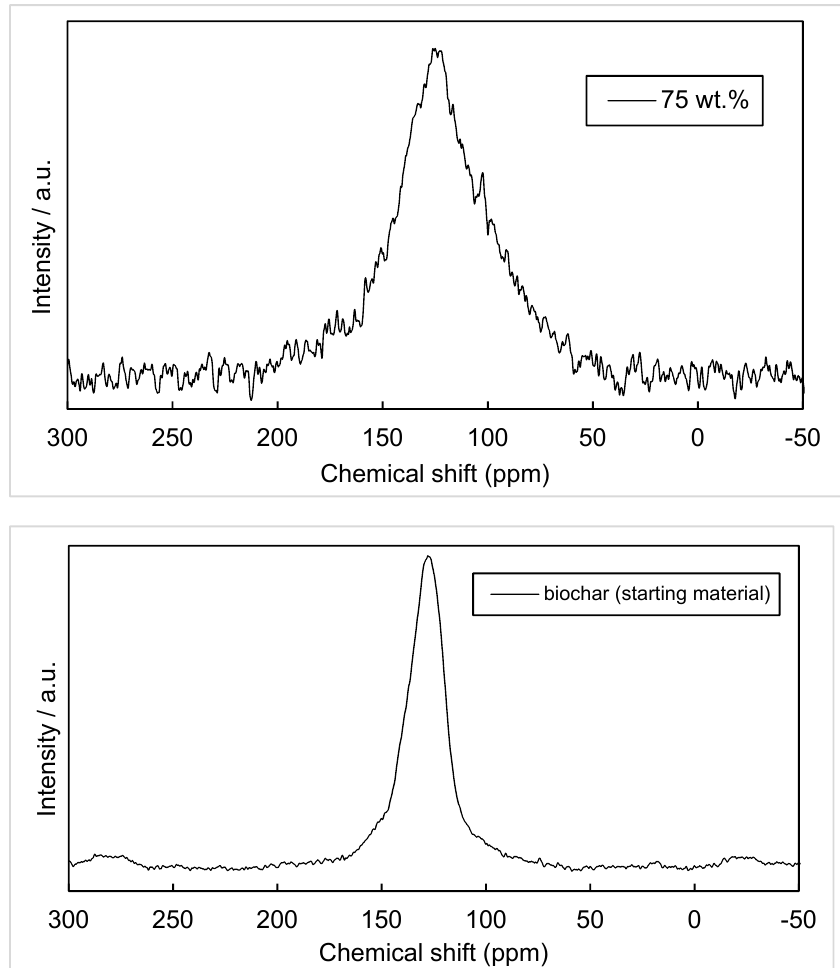
Figure 6. The solid 13 C-NMR of the biochar (starting material) and the KOH 75 wt.% activated sample.